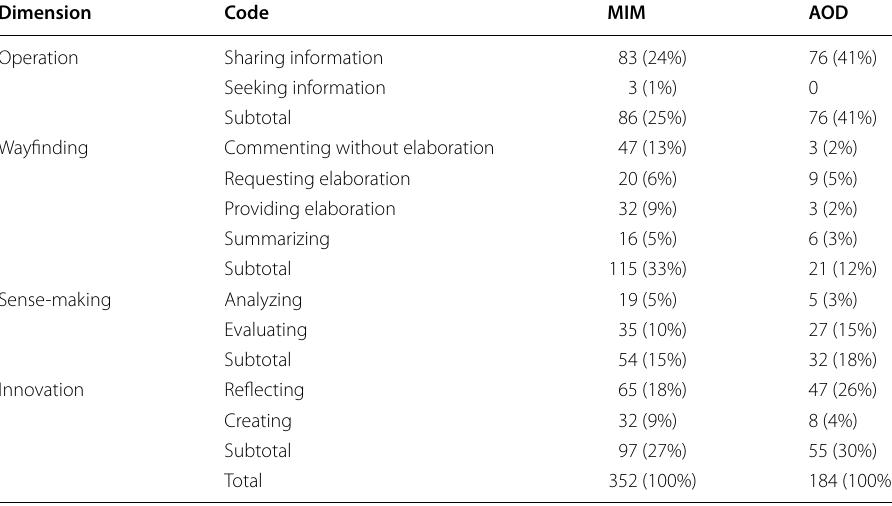
Table 6 Differences in cognitive engagement reflected in students’ posts Dimension Code MIM Operation Sharing information